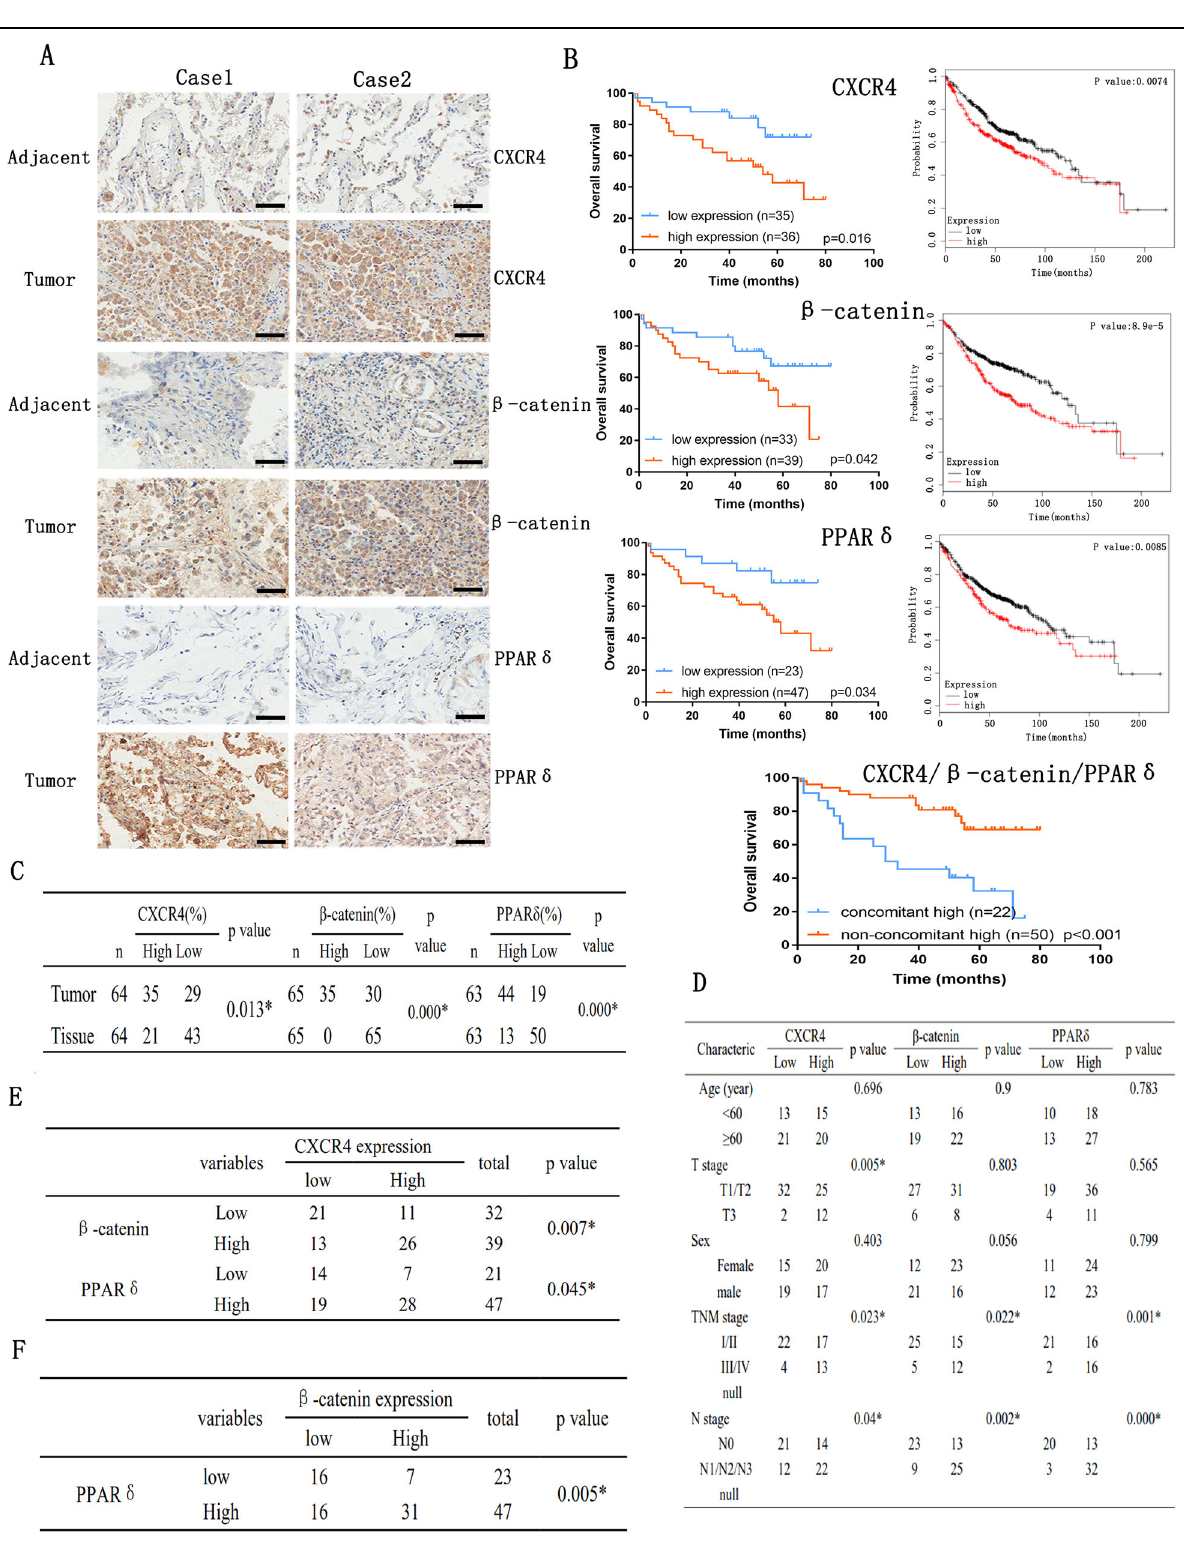
Fig. 7 (See legend on next